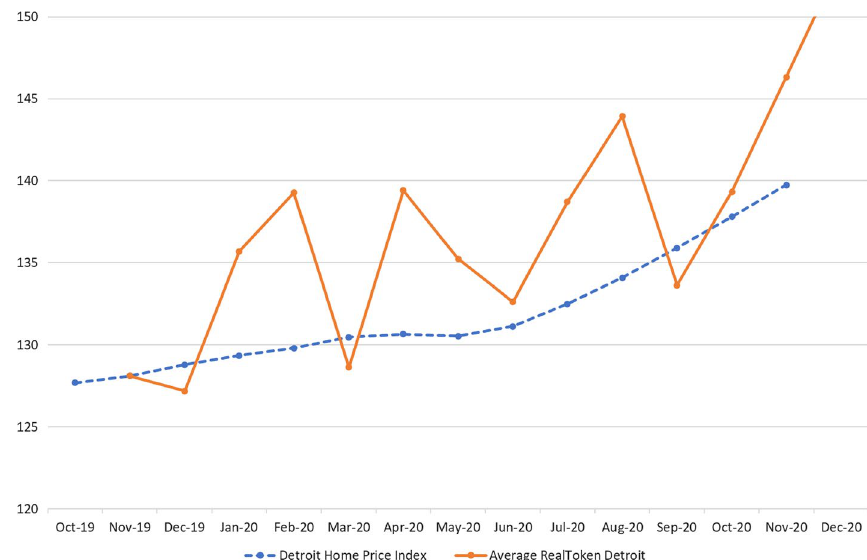
Fig. 8 Home price index for Detroit MI and average RealToken Price. Source: S&P/Case-Shiller MI-Detroit Home Price Index, downloaded from